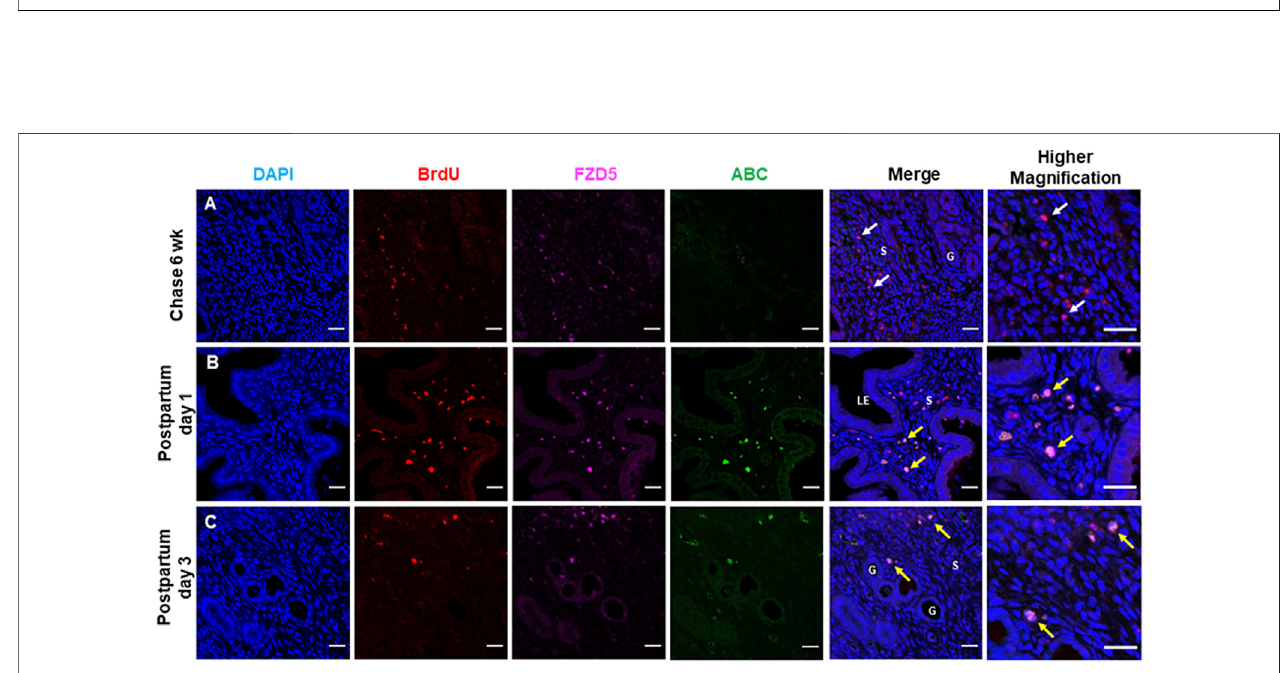
FIGURE 7 | Label retaining stromal cells express FZD5 receptor and active β -catenin. Representative immuno fl uorescence images showing the label retaining stromal cells (LRSCs: BrdU + cells, red) at (A) 6 weeks chase ( white arrow ), (B) PPD1, and (C) PPD3 colocalized with FZD5 (pink). Triple staining of BrdU/ABC/FZD5 ( yellow arrow ) in PPD1 and PPD3. Scale bar: 20 μ m, 10 µm. Abbreviations: ABC, active β -catenin; BrdU, bromodeoxyuridine; FZD, frizzled; G, gland; LE, luminal epithelium; PPD, postpartum day; s, stroma.